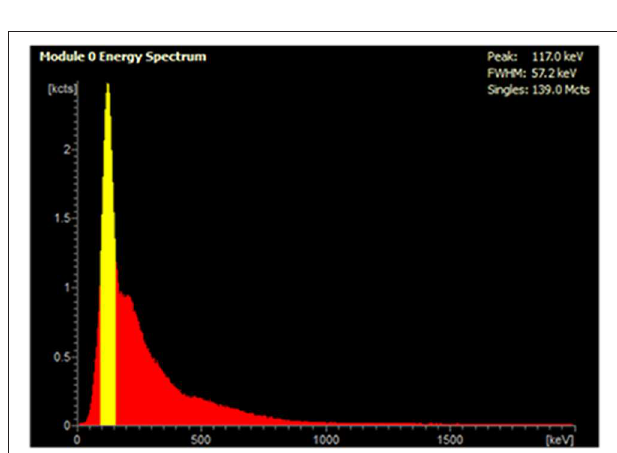
FIGURE 2 | Live acquisition energy spectrum obtained during a PET scan of a mixed radionuclide phantom containing 5 MBq 18 F and 250 MBq 99m Tc. The yellow peak at 140 keV corresponds to the energy of 99m Tc γ photons, which reduces detection of 18 F coincident photons at 511 keV.